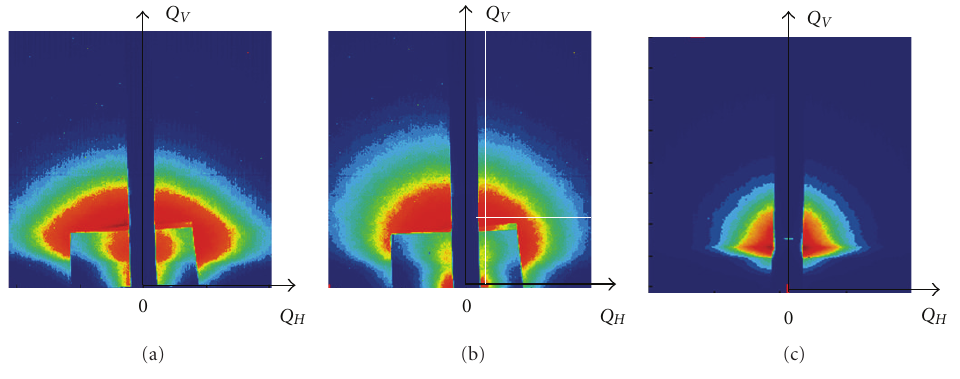
Figure 5: 2D GISAXS patterns of sample A (a), sample B (b), and sample C (c).